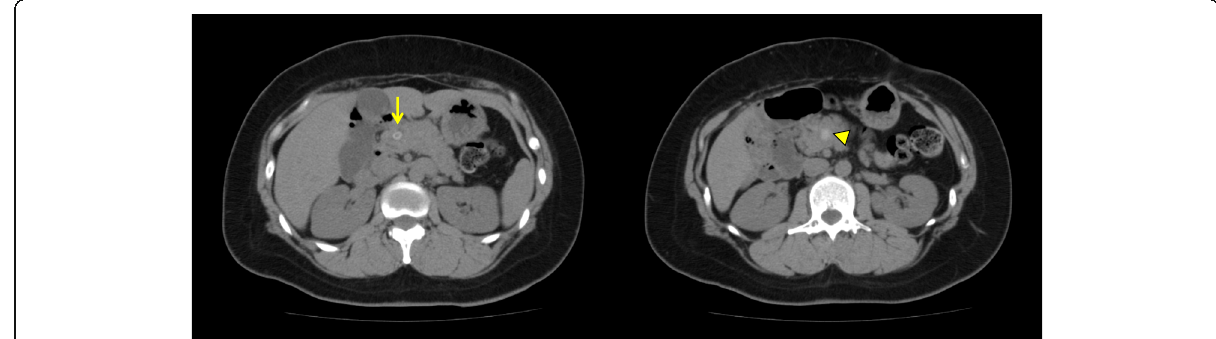
Fig. 1 Findings of computed tomography. The choledocholithiasis (arrow) and pancreatic calculi (triangle) was